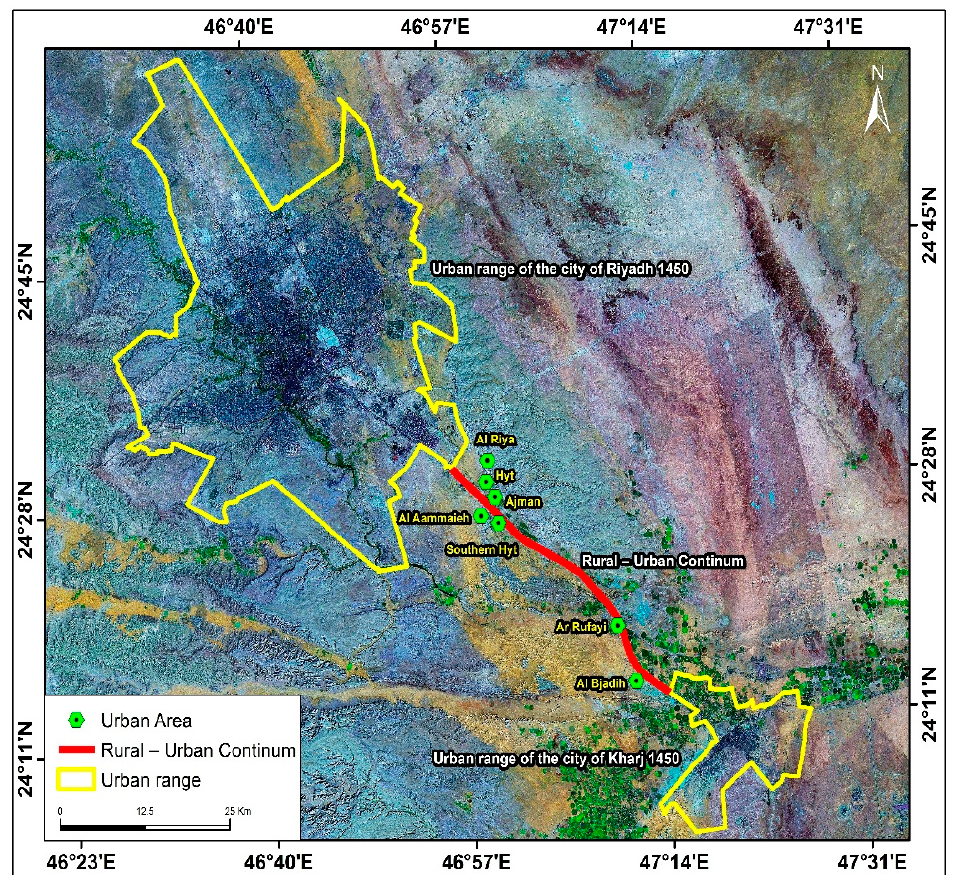
Figure 2. The rural–urban continuum between Ar Riyadh and Al Kharj cities, 2019.